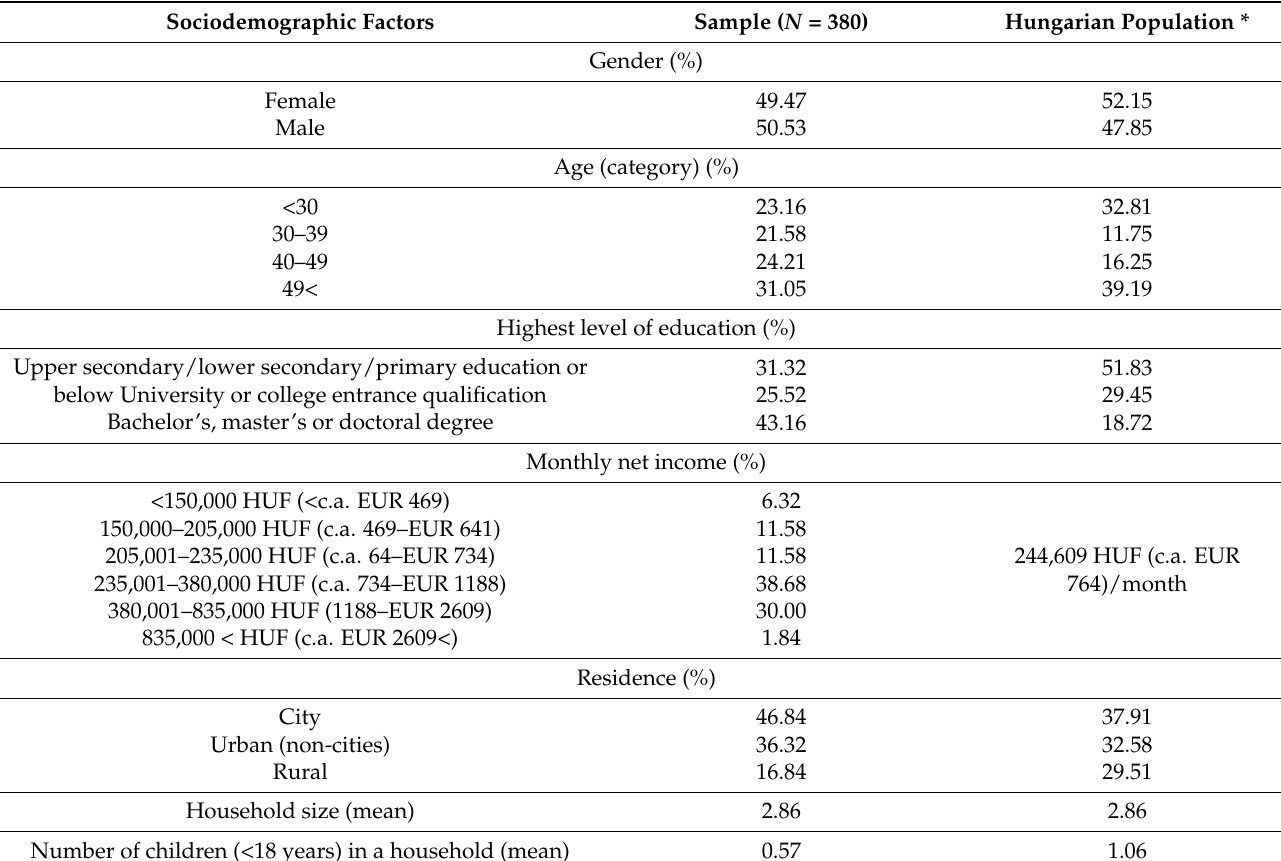
Table 2. Sociodemographic characteristics of